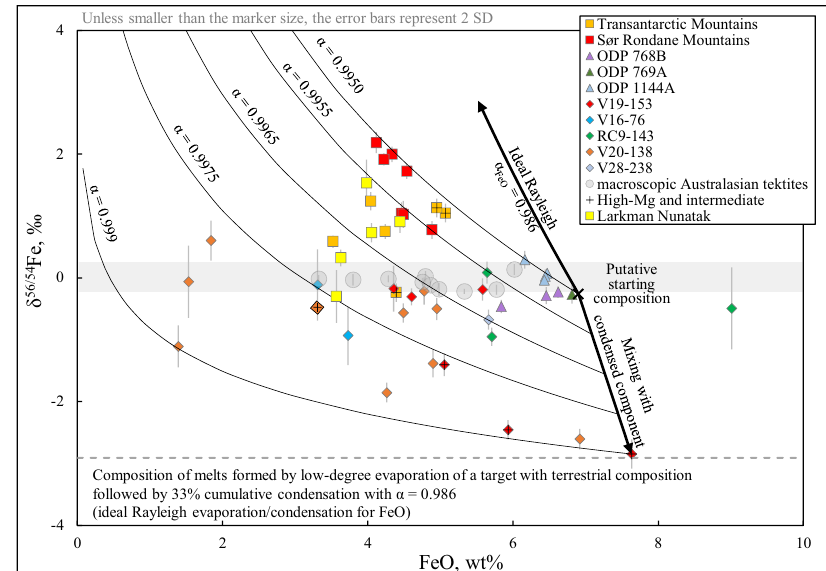
Fig. 4 Diagram of δ 56/54 Fe versus FeO. The shaded horizontal area indicates the Fe isotopic composition in macroscopic Australasian tektites. The average composition of the upper continental crust (FeO = 6.9 wt%, δ 56/54 Fe = − 0.263 ‰ ) suggested to be the starting composition for the Australasian strewn fi eld. A range of Rayleigh evaporation trends predicted using different fractionation factors α are shown. The Rayleigh fractionation trend under ideal conditions of evaporation to vacuum predicted by the Hertz – Knudsen equation is shown as a thick line. The downward shift of certain microtektites from the upper crust δ 56/54 Fe – FeO composition is best explained by a mixing line between the pristine melt and condensed